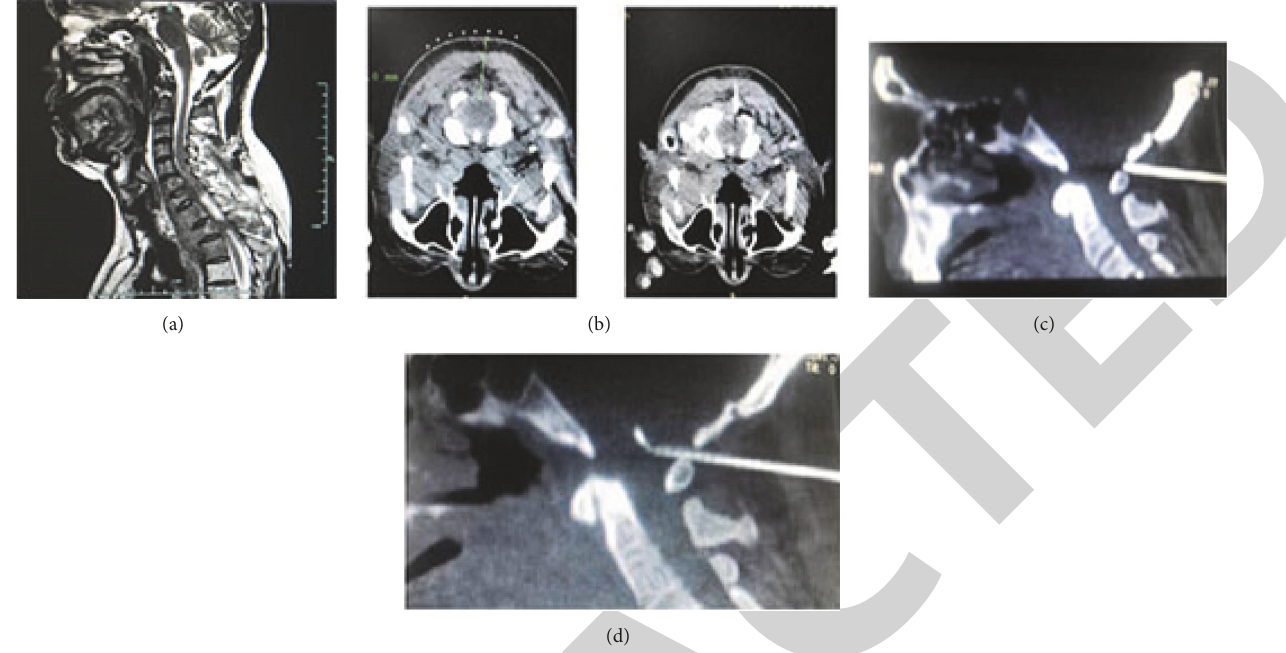
Figure1:IntrathecalpumpwasimplantedinthecisternamagnaunderDSA,locatedinmidpointofcisternamagna.Aftersuccessfulpuncture, the catheter tip was inserted 3-4cm towards the head, pull out the puncture needle, and moved to the interspinous